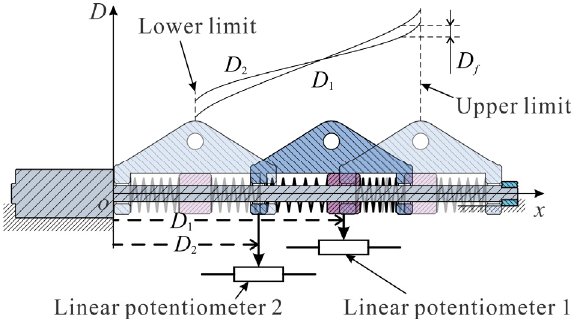
Figure 4. Initial measurement error D f of the spring deformation due to the different nonlinearity distribution characteristics of D 1 and D 2 .